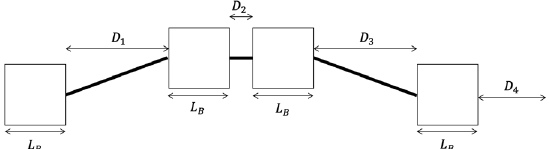
FIG. 9. Layout of 4-Bend bunch compressor (not to scale) used in the LCLS-II CuRF and LCLS-II-HE beam